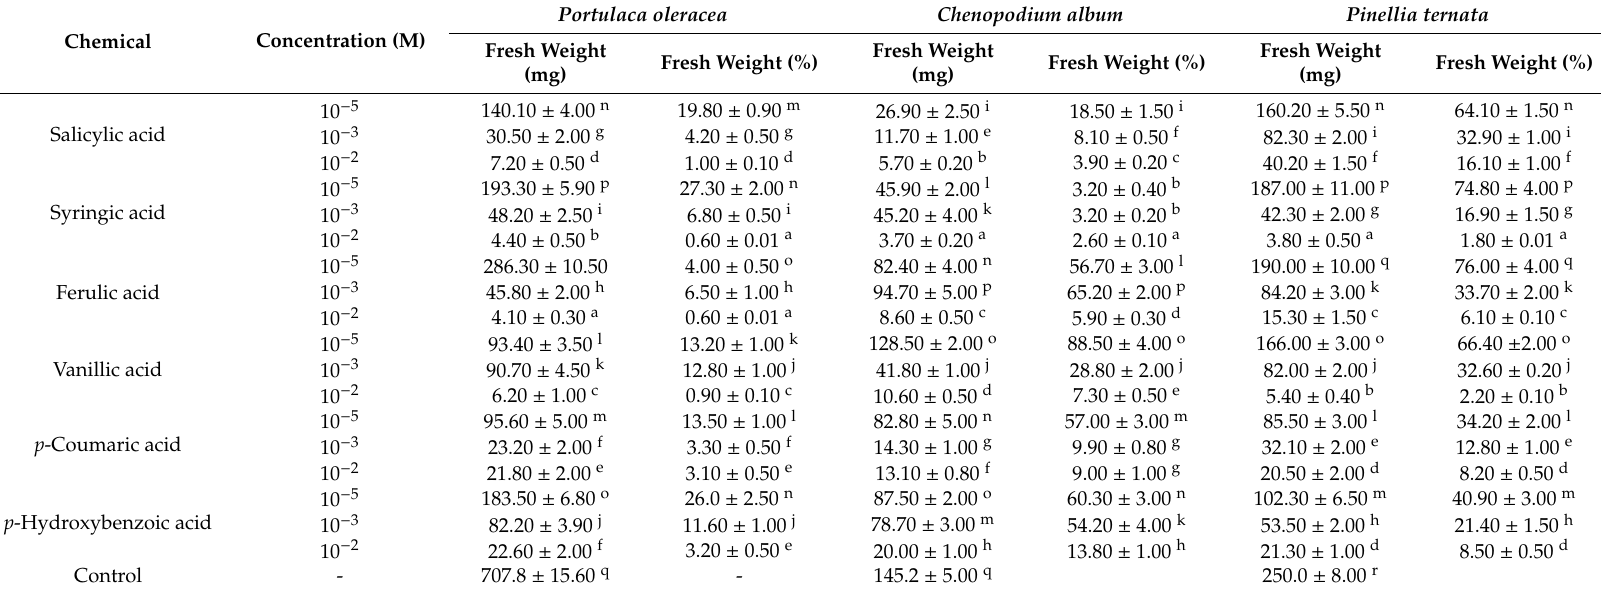
Table 3. E ff ect of standard phenolic compounds on callus fresh